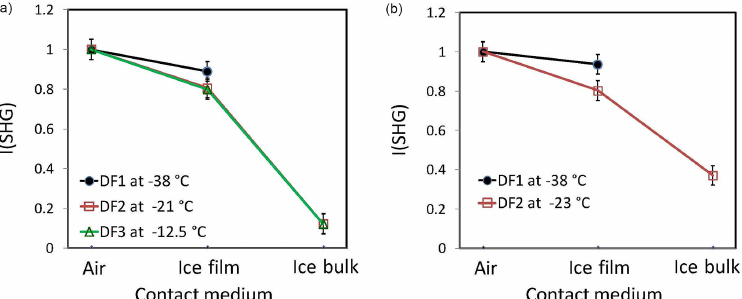
Figure 3. SHG intensity measured at the surfaces of mica (a) and sapphire (b) in contact with air, ice film, and ice bulk, collected in an SM polarization combination during the three different cooling cycles. DF1: sample cooled down first to − 38 ◦ C under dry N 2 gas, followed by pumping water vapor of RH = 5% to the measuring cell. DF2: sample cooled down under flow of water vapor of RH = 5%. DF3: sample cooled down under flow of water vapor of RH = 10%. The signal is Fresnel-corrected and normalized to the air value. All connection lines between points serve to guide the